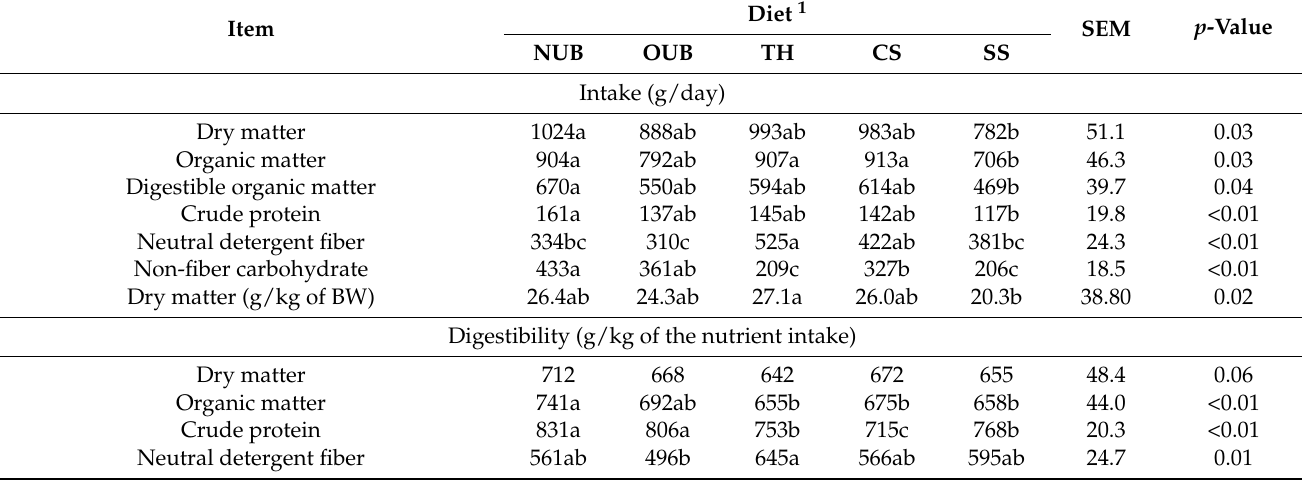
Table 4. Mean values for nutrient intake and digestibility in